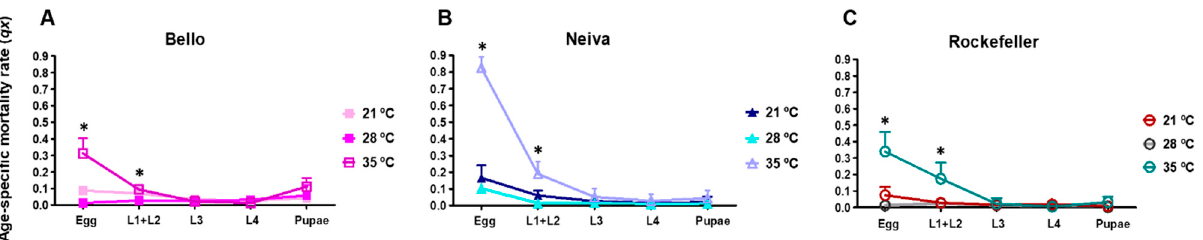
Figure 10. Age-specific mortality rate ( qx ) at 21, 28, and 35 °C, 80 ± 5% relative humidity, and 12 h light: 12 h dark photoperiod. ( A ) Bello, ( B ) Neiva and ( C ) Rockefeller. Mean and standard deviation (SD) are shown. One-way analysis of variance (ANOVA) was conducted (* p < 0.05). A Bonferroni post-hoc test to account for multiple comparisons between temperatures for qx within the same population and developmental stage is presented in Table S12.